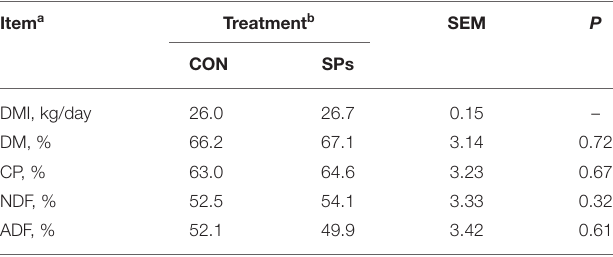
TABLE 4 | Effects of the dietary supplementation of soybean peptides (SPs) on feed intake and apparent total tract digestibility in lactating dairy cows. Item